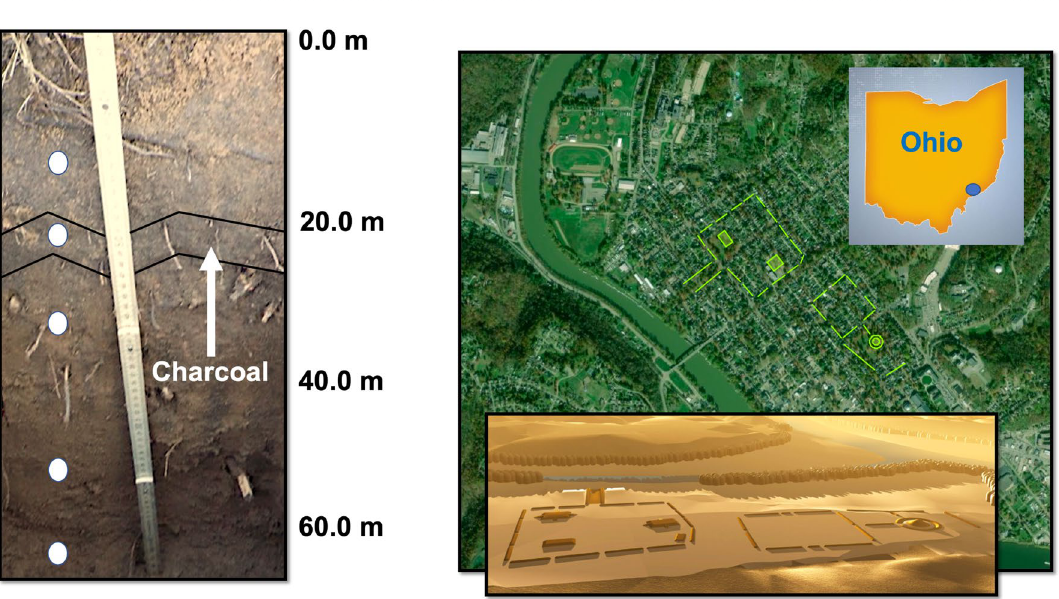
Figure 11. The location, stratigraphy, and sample sites (white circles) of the Marietta earthworks and mounds site, Washington County, Ohio. Kenneth Barnett Tankersley used Microsoft PowerPoint for Mac Version 16.41 (www. micro soft. com) to create this